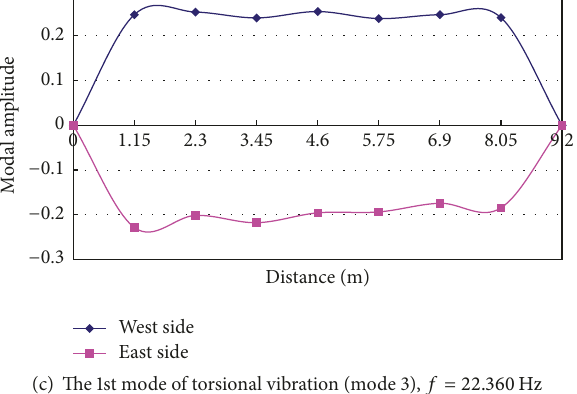
Figure 6: ((a)–(c)) Measured frequencies of girder No. 3 in May